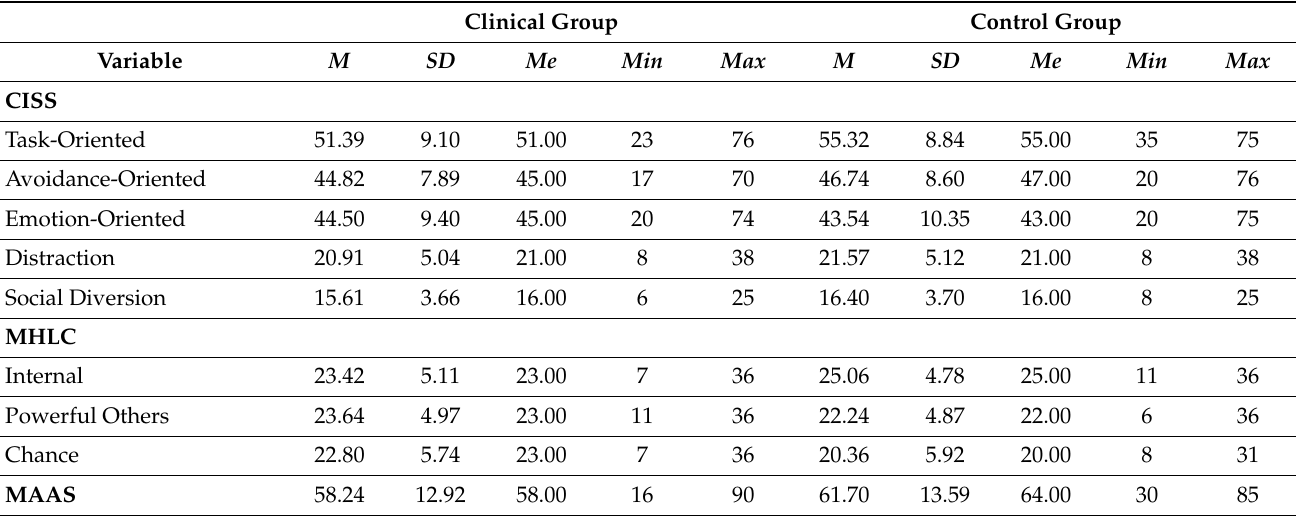
Table 2. Basic descriptive statistics of psychological variables in the studied groups.